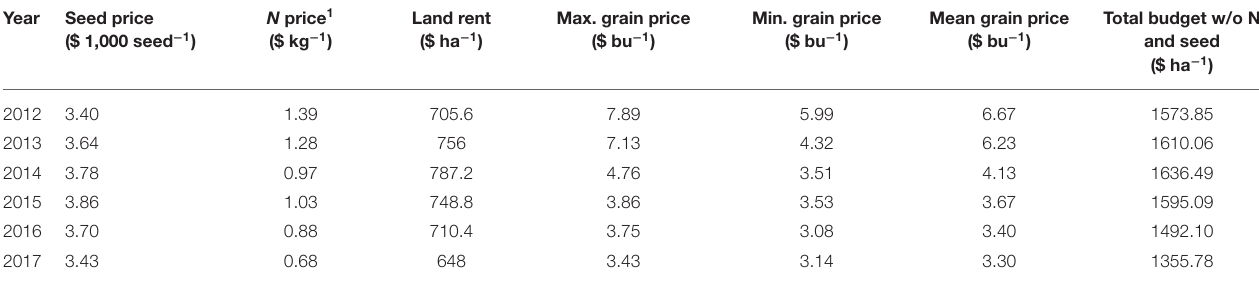
TABLE 3 | Annual crop production cost estimates and maize grain